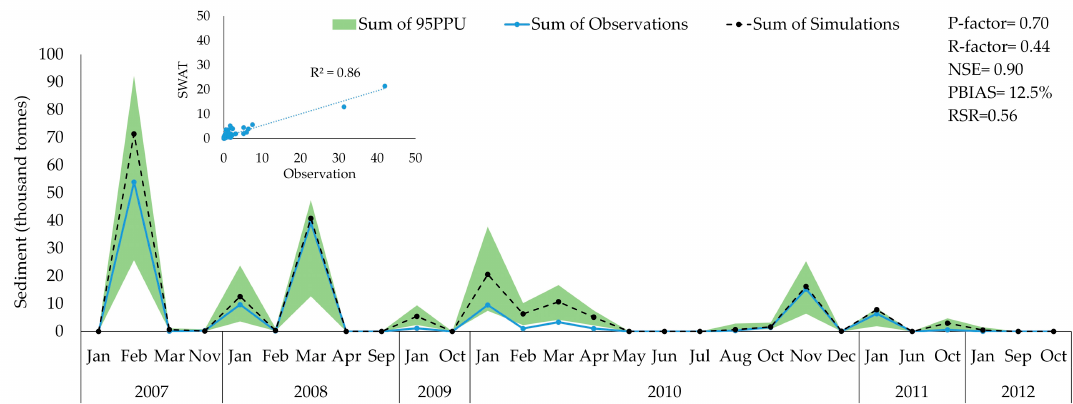
Figure 6. Results of validation and uncertainty analysis for sediment loads, showing aggregated values for each month of the best simulation, 95PPU, and the observation in the period between 2007 and 2012 at the Tung Oil station. The scatter plots show the best simulation versus the observation while the main graphs represent the monthly aggregated sediment loads.